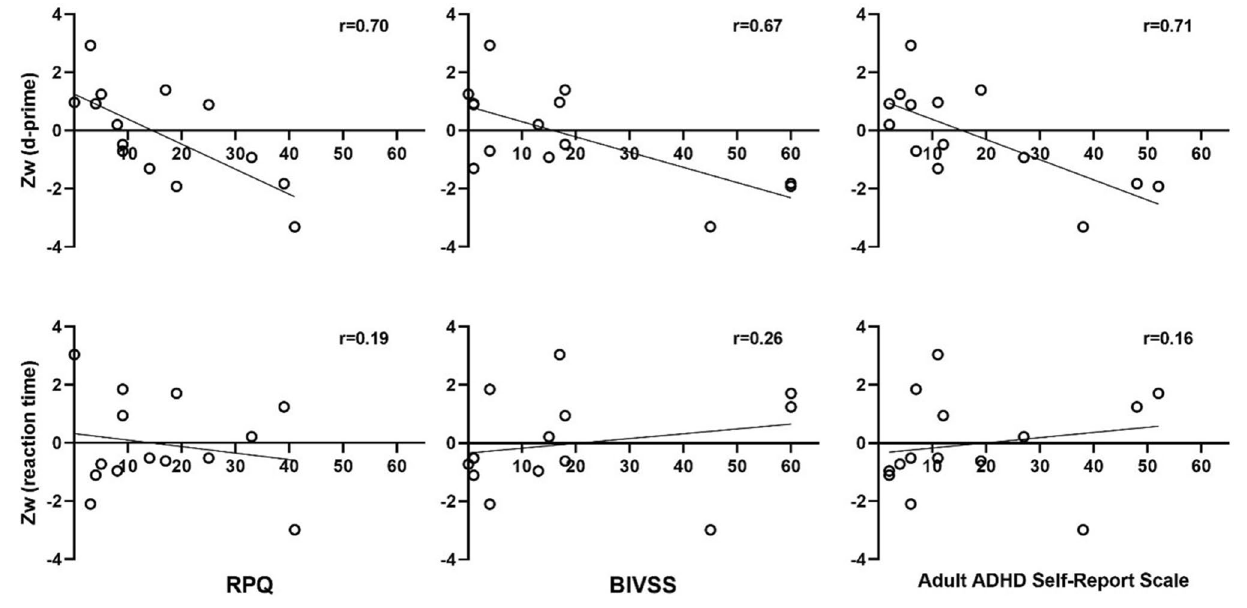
Figure 5. The association between the overall MOT performance (sensitivity and reaction time) as measured by weight-averaged Z-scores and symptoms scores for RPQ, BIVSS questionnaire, and the Adult ADHD Self-report Scale. Circle markers in each graph indicate individual subjects and the solid line represents the line of best fit.